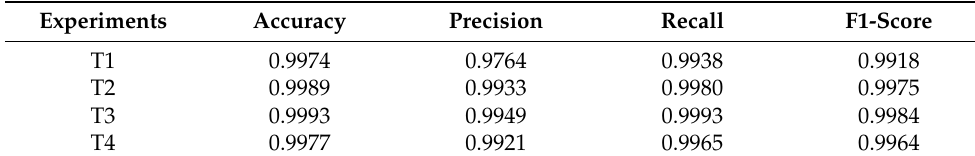
Table 2. A summary of achieved metrics in all the experiments.